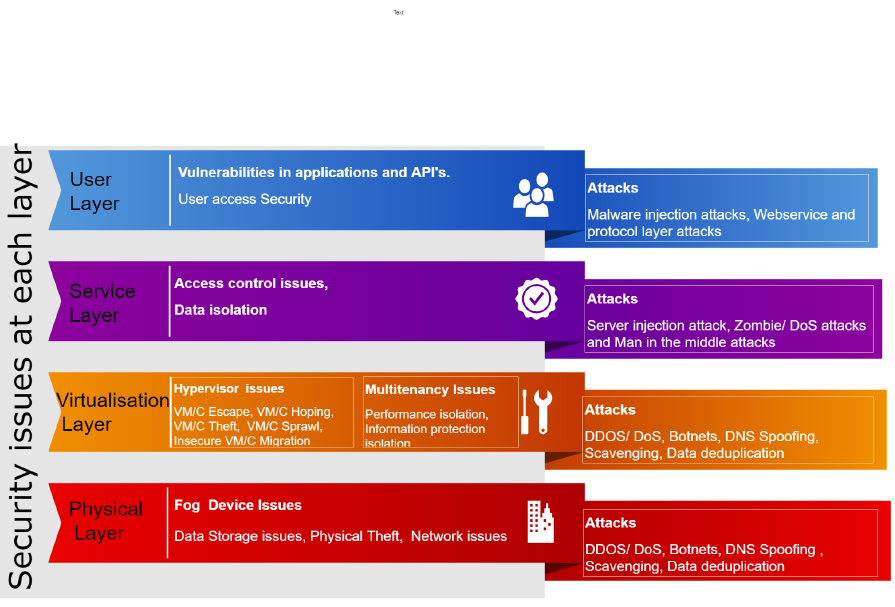
Figure 1. Security issues and attacks at each